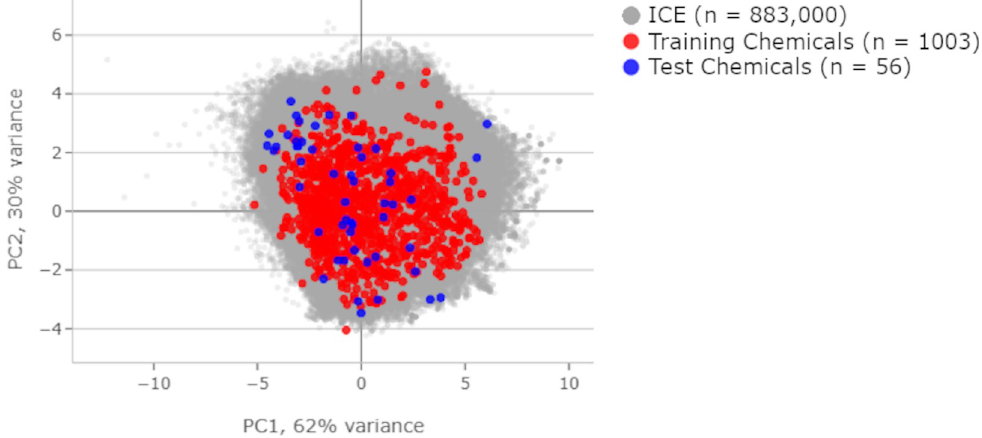
Fig 3. Data subdivision. Principal component analysis displayed against the background of over 800,000 chemicals in the Integrated Chemical Environment database. Compares physical chemical properties between the training and test sets.